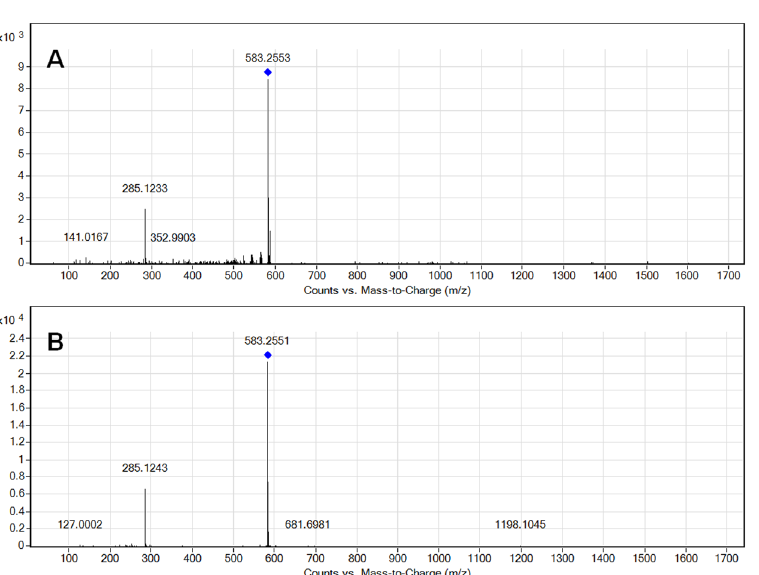
Figure 2. Comparison of bilirubin IXa MS/MS spectra between a pooled serum sample ( A ) and a commercial standard ( B ). Both fragmentation spectra show matches for residual precursor [M-H] − (m/z 583) and a prominent fragment ion (m/z 285) with MS/MS data acquired at a fixed collision energy (CE) of 10 V and the mass spectrometer operated in negative ionization